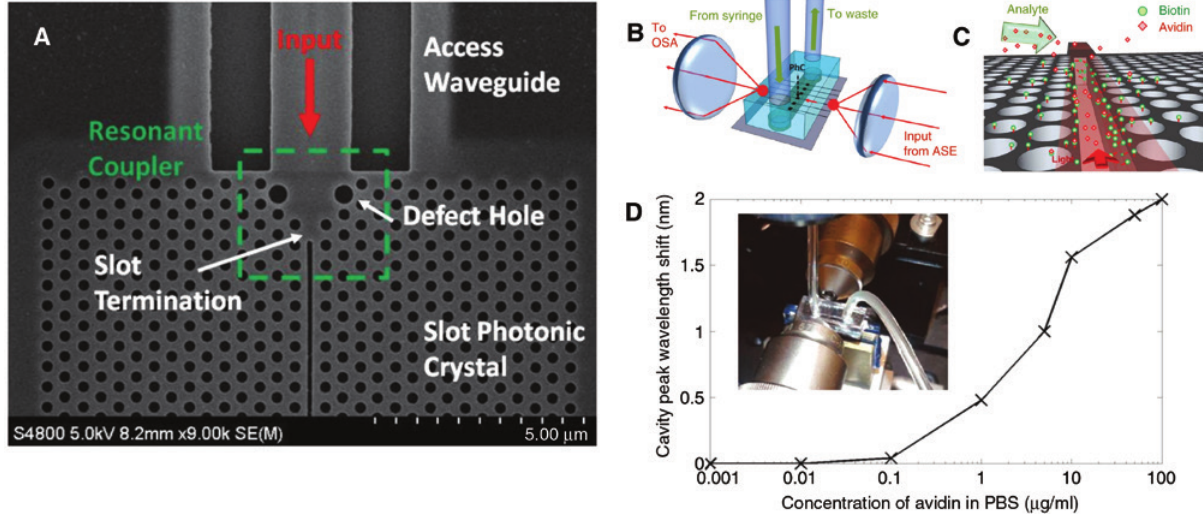
Figure 25: An example of a slotted PhC design. (A) SEM image of a slotted PhC fabricated in an SOI wafer, with resonant defect couplers and access waveguides, and (B) schematic of the experimental setup. (C) Depiction of avidin binding to a biotin-coated slotted PhC biosensor and (D) the induced cavity peak wavelength shift (wherein the inset is the experimental arrangement for fluid injection into the slotted PhC chip). Adapted from [141] and